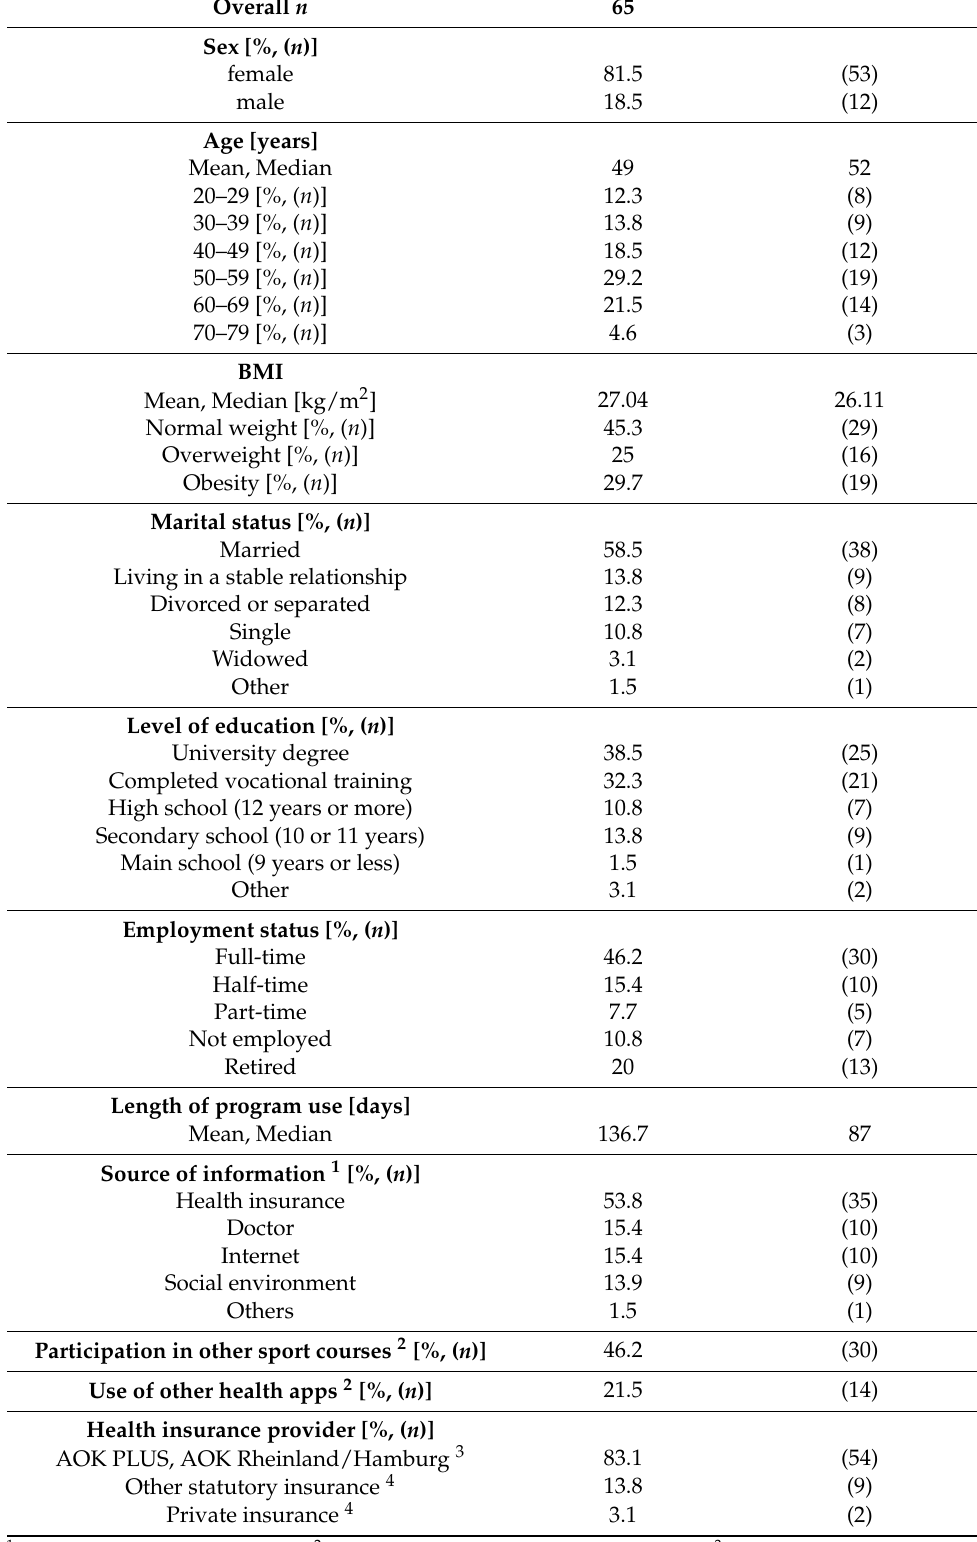
Table 1. Characteristics of the study